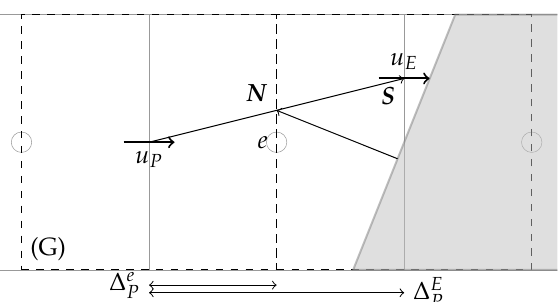
Figure 8. Computation for diffusive contribution requires vector S defined from u P to u E and normal vector from surface N which intersects with S in the e face.